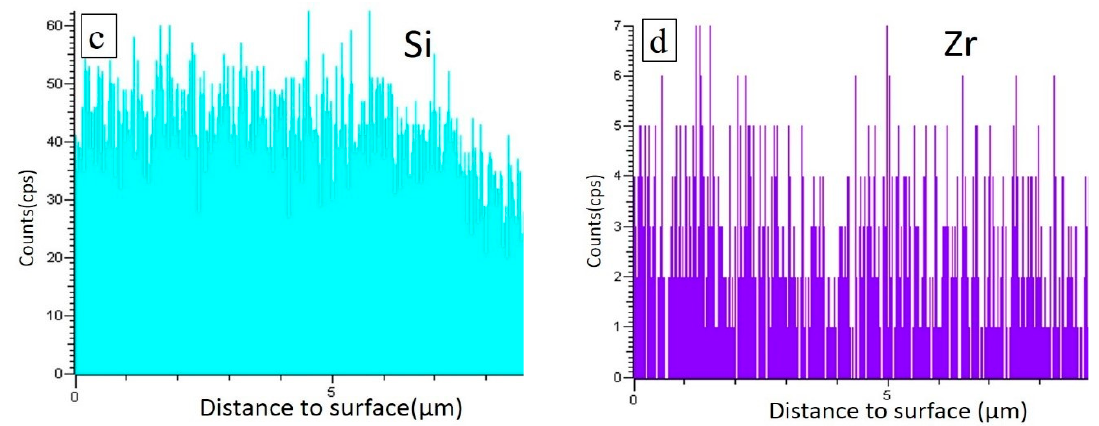
Figure 1. Scanning electron microscopy (SEM) images of the surface ( a ) and cross-section ( b ) of the electron-beams (EB)-cured polyzirconocenecarbosilanes (PZCS) fiber and X-ray energy dispersive spectrometer (EDS) images ( c ) and ( d ) from surface to core of the fiber.